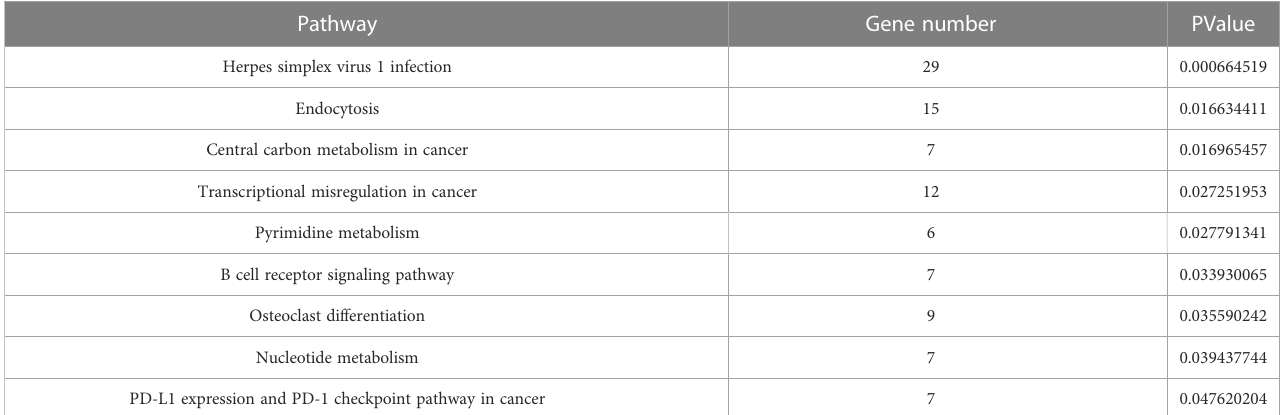
TABLE 4 KEGG enrichment pathways with signi fi cance.